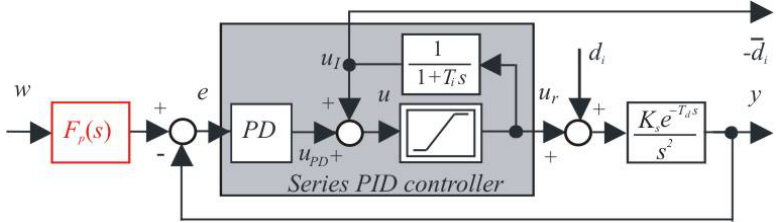
Figure 2. Creating 2DOF series PID controller from PD controller for DIPDT